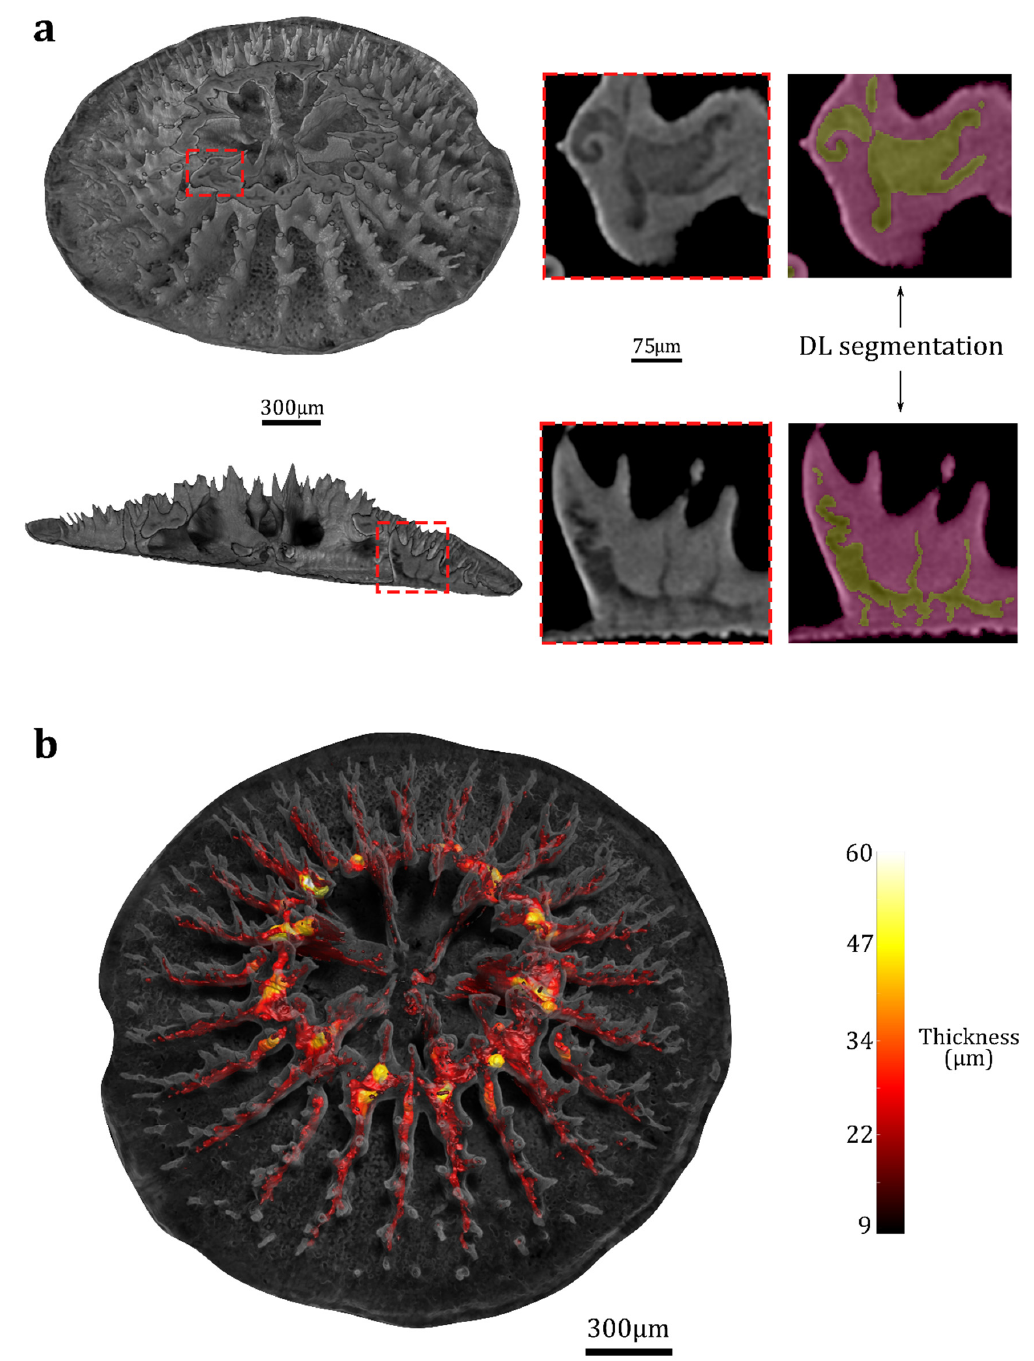
Figure 6. Deep-Learning-based image segmentation and quantitative 3D reproduction of segmented RADs and TDs. ( a ) Two example 3D renderings of a primary polyp skeleton virtually sliced in the transverse plane (upper row) and in the longitudinal plane (bottom row). Red dotted lines show enlargements of the sliced skeleton that have been segmented using DL (segmented TDs and RADs are colored in pink and yellow, respectively). DL, Deep Learning. ( b ) Segmentation of RADs and TDs across the entire stack of slices allows 3D separation of features and quantification, including details of local thickness (µm).